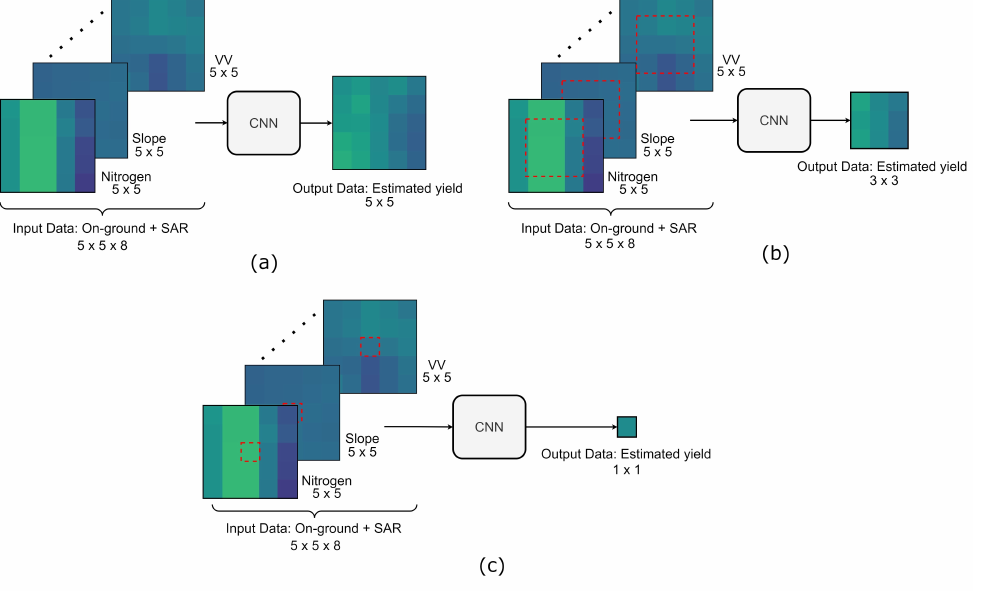
Figure 2. Proposed yield prediction model using different output window sizes: ( a ) 5 × 5, ( b ) 3 × 3, and ( c ) 1 ×